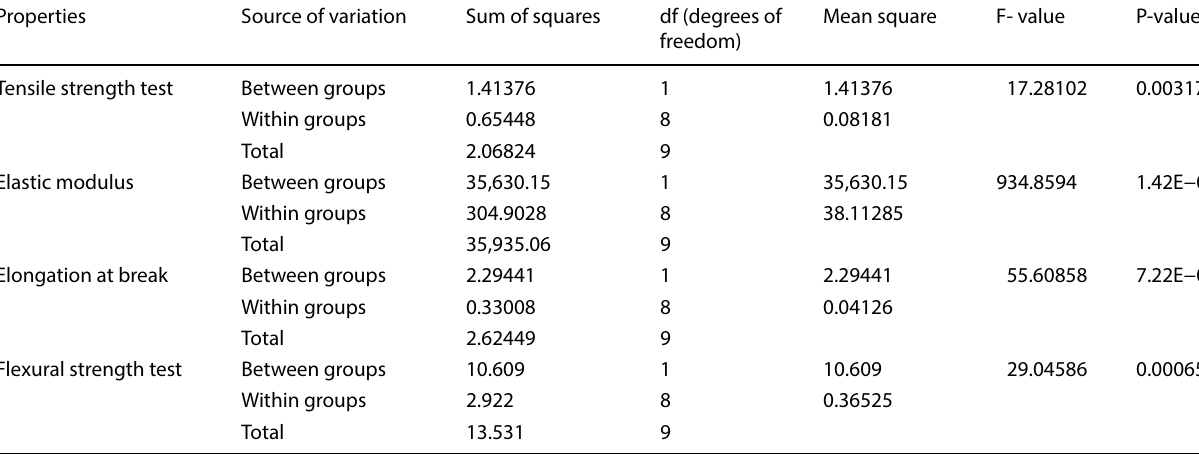
Table 6 ANOVA of tensile and flexural strength test